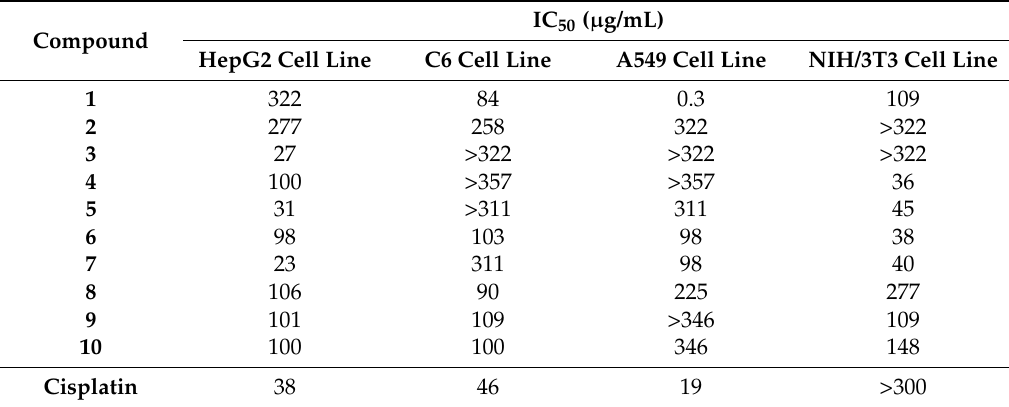
Table 4. SI values of compounds 1 – 10 .